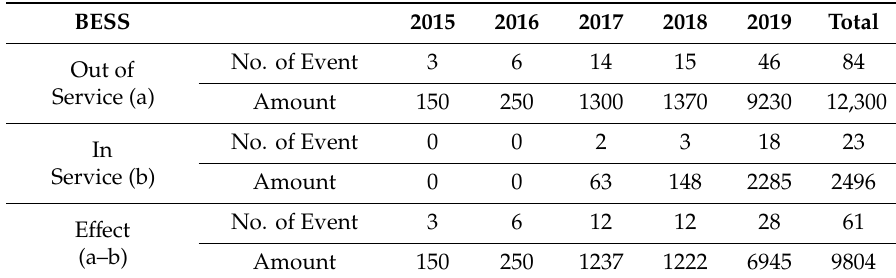
Table 8. E ff ect of mitigating renewable energy curtailment using BESS for improving frequency stability from 2015 to 2019 (MWh).